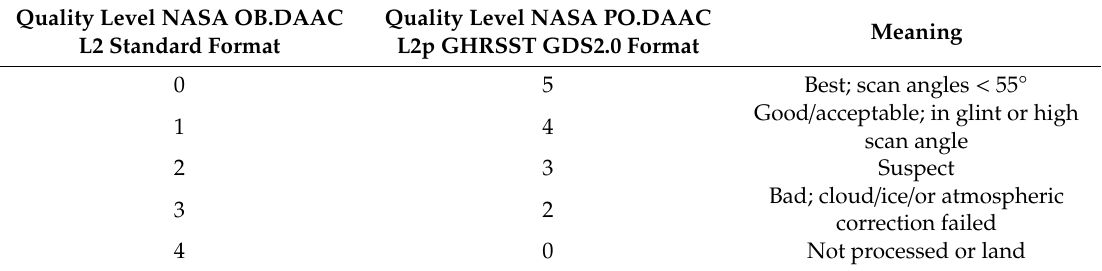
Table 3. Quality level definitions and conventions used by di ff erent archive centers. Here we use the Ocean Biology Processing Group (OBPG) convention in all